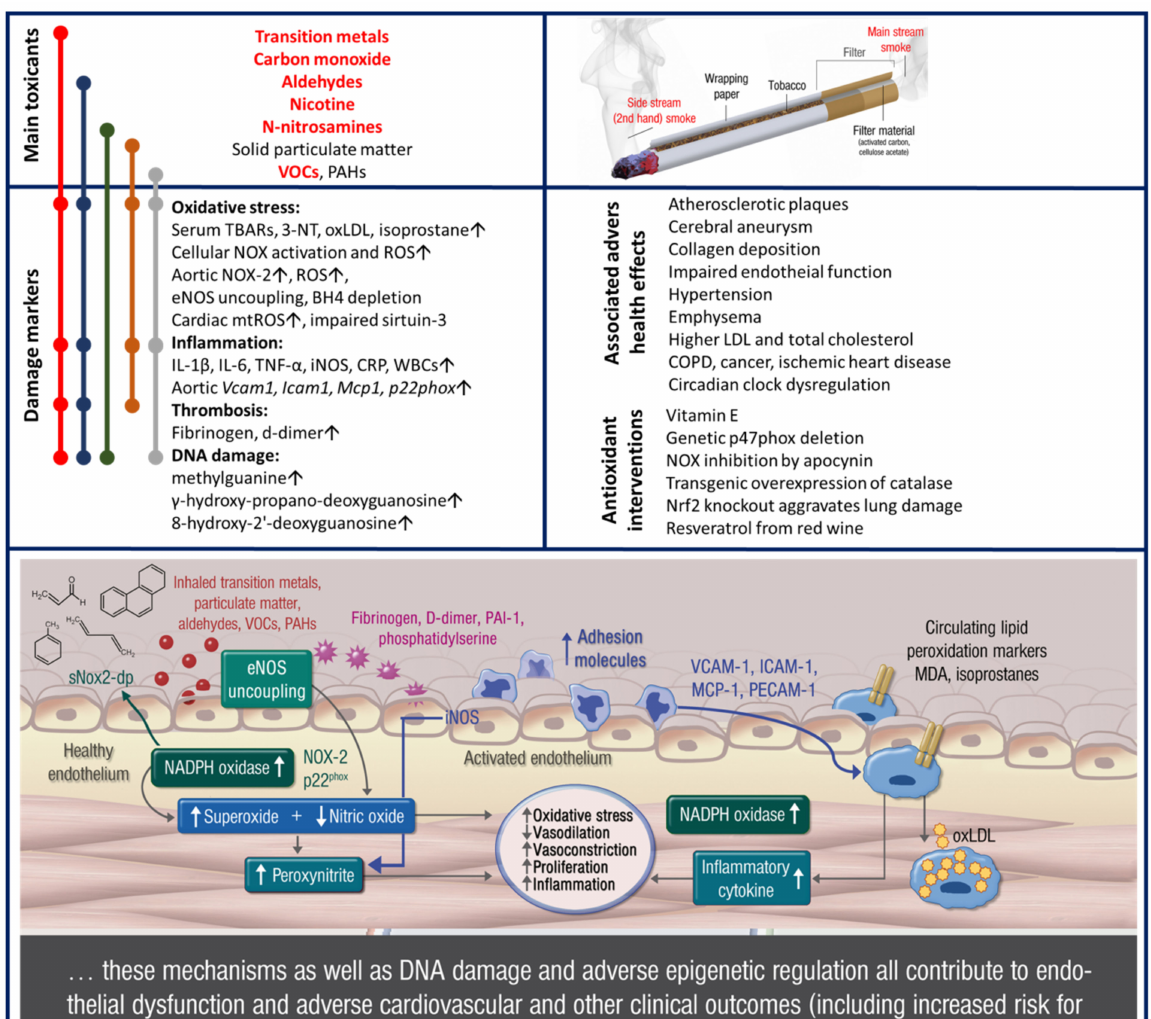
Figure 3. Toxic compounds, pathomechanisms, and adverse health effects of smoking as summarized from human and animal studies: The major toxicants (red and bold = high quantity, black = intermediate quantity) that are associated with smoking are listed along with a schematic description of the specific features of a tobacco cigarette. The molecular link between these toxicants and major damage markers reported for smoking with respect to oxidative stress is shown on the left side. The effects of these toxicants on endothelial (vascular) function are summarized in the inserted scheme. The associated adverse health effects as well as antioxidant interventions are also shown. Modified from Münzel et al. [41] with permission. Copyright © 2020, Oxford University